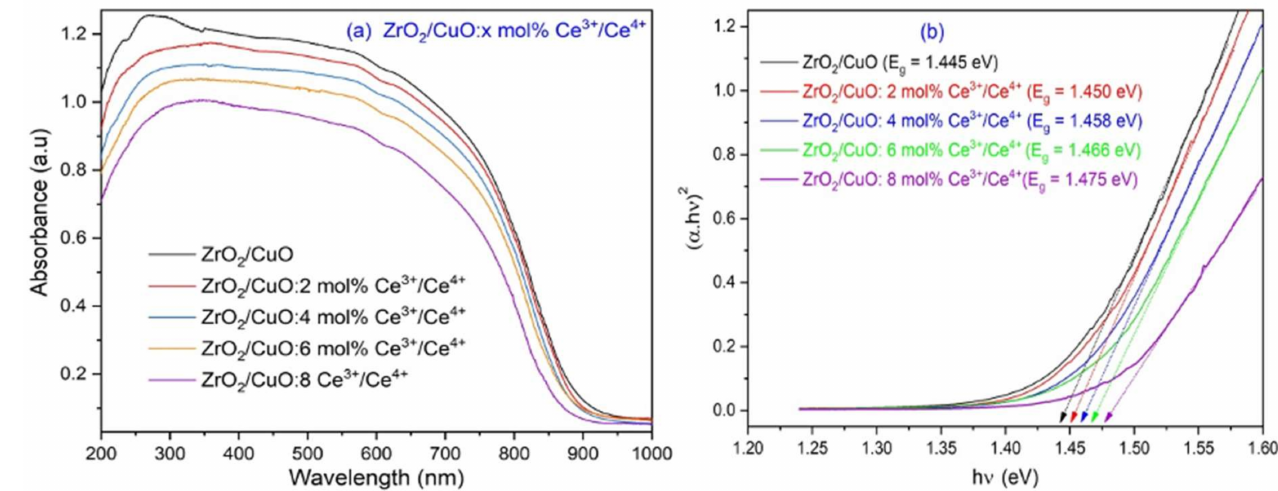
Figure 6. ( a ) The UV-Vis DRS and ( b ) The Kubelka-Munk energy curve versus the band gap (eV) of the x mol% Ce 3+ /Ce 4+ -doped ZrO 2 /CuO (x = 0; 2; 4; 6;